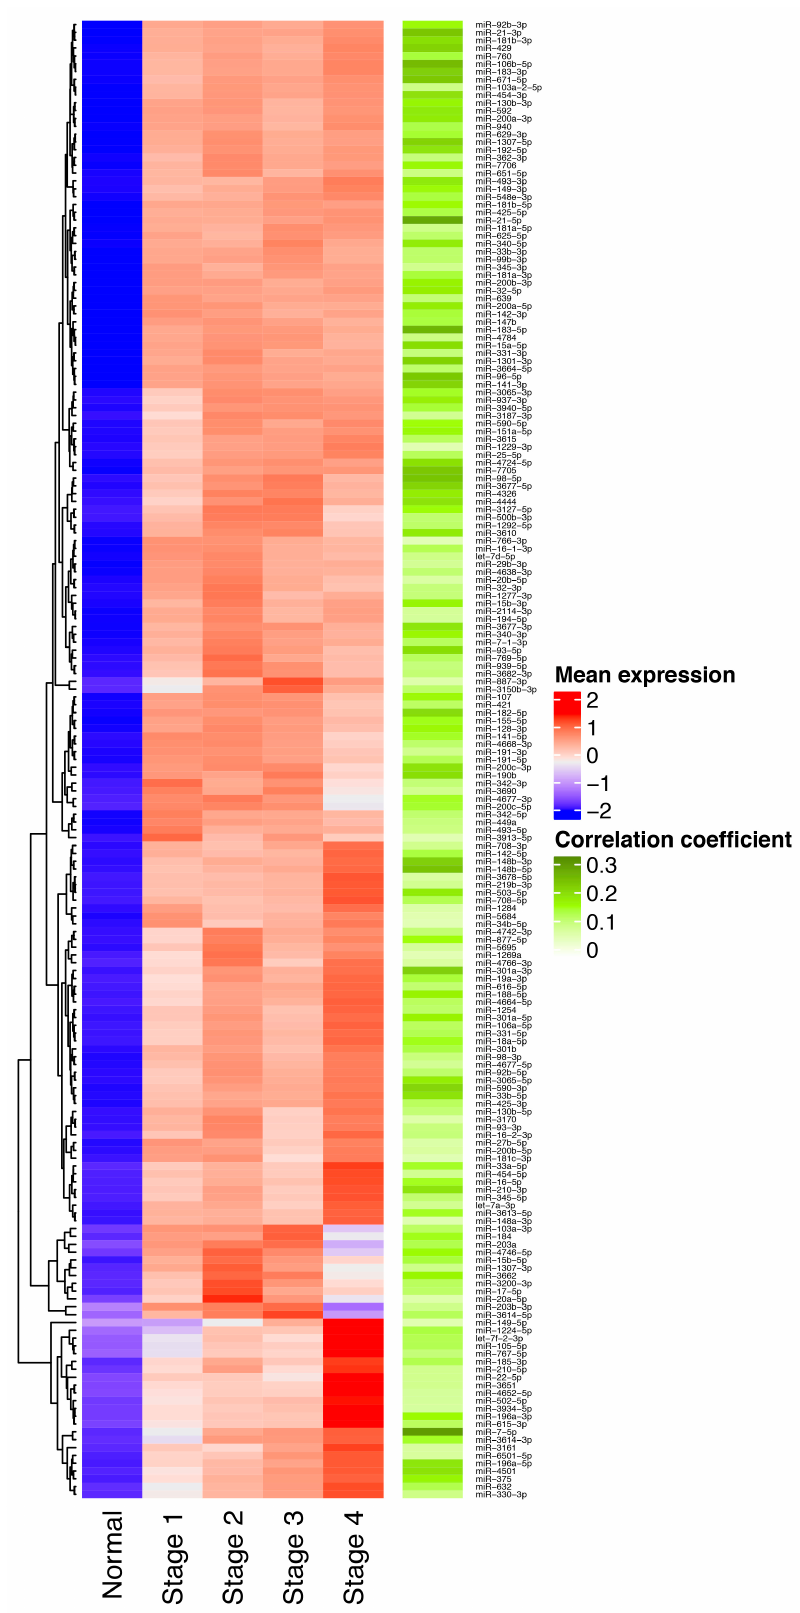
Figure 2. Overexpressed miRNAs across all clinical stages. The left heatmap shows the expression of 217 miRNAs over-expressed in breast cancer (BC) tissues (depicted in red) and downregulated in normal tissues (blue). As shown the majority of miRNAs had a positive correlation (green) between expression level and clinical stage.